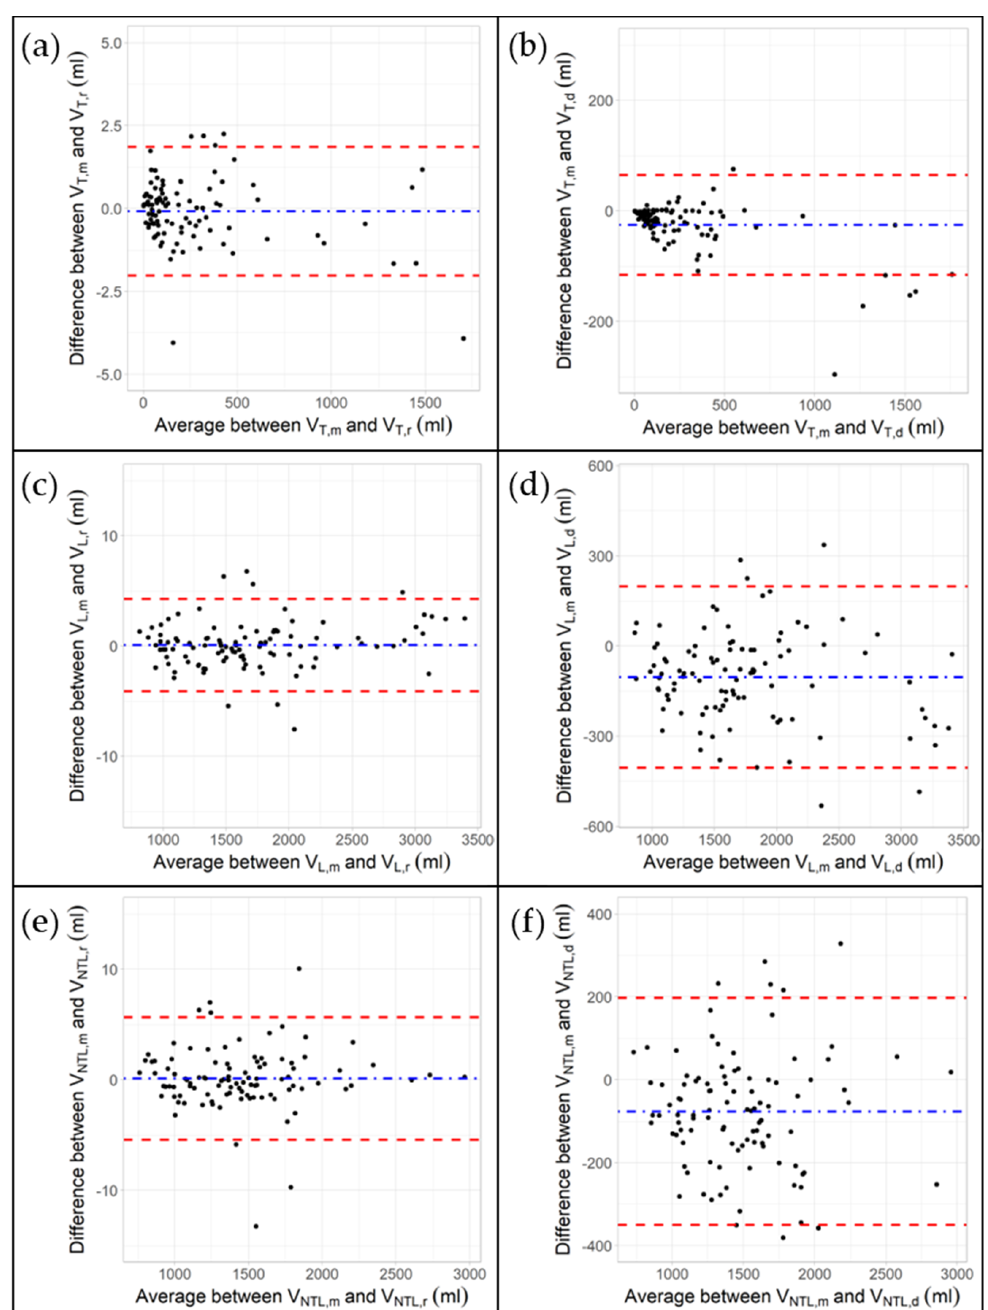
Figure 2. Bland–Altman plots for tumor (i.e., panels ( a , b )), whole liver (i.e., panels ( c , d )) and NTL (i.e., panels ( e , f )) volumes according to the contouring approach.